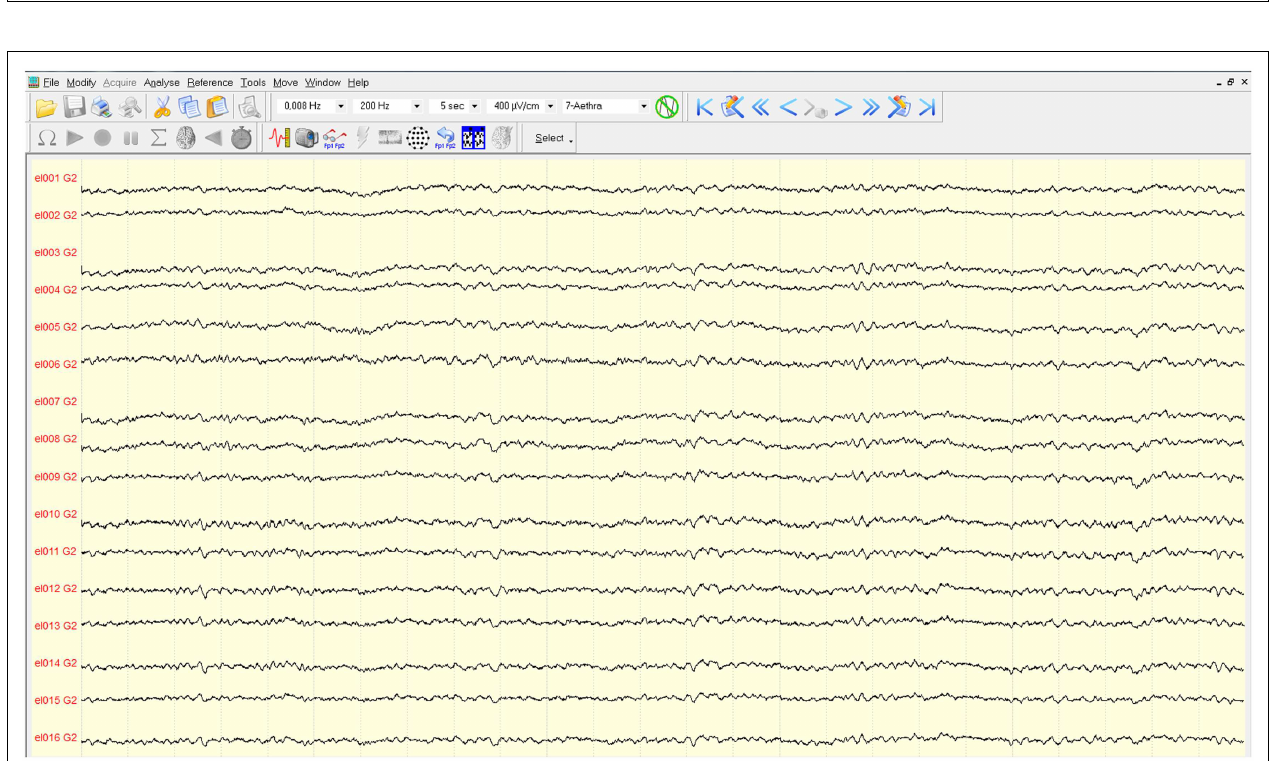
FIGURE 3 | Scheme showing the position of the device: it is made by three elements, the electrode grid, the antenna, and the body .The body is in contact with the monkey skull and fixed to it using sutures and titanium screws.The electrode grid was in contact with the cortex and secure to the